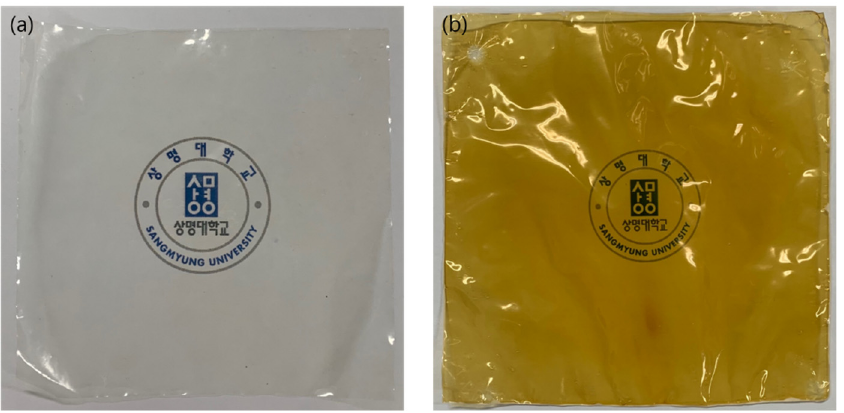
Figure 4. Pictures of ( a ) pore-filled anion-exchange membrane (PFAEM-1) and ( b ) pore-filled cation-exchange membrane (PFCEM-1).